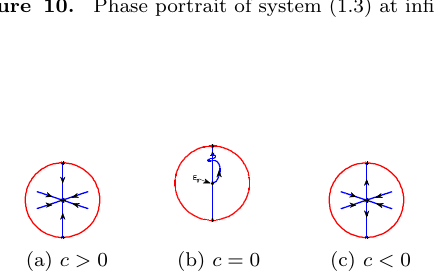
which is shown in Figure 12.